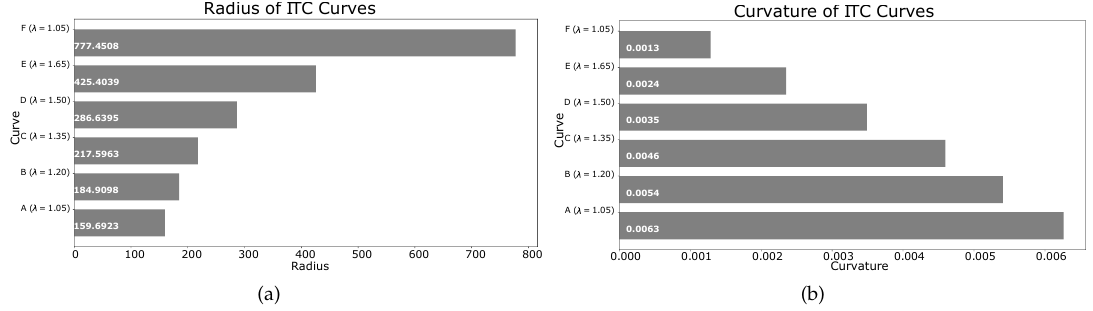
Figure 26. Radius and curvature of curves corresponding to different λ in Figure 25. ( a ) radius of curves at different points; ( b ) curvature of curves at different points.